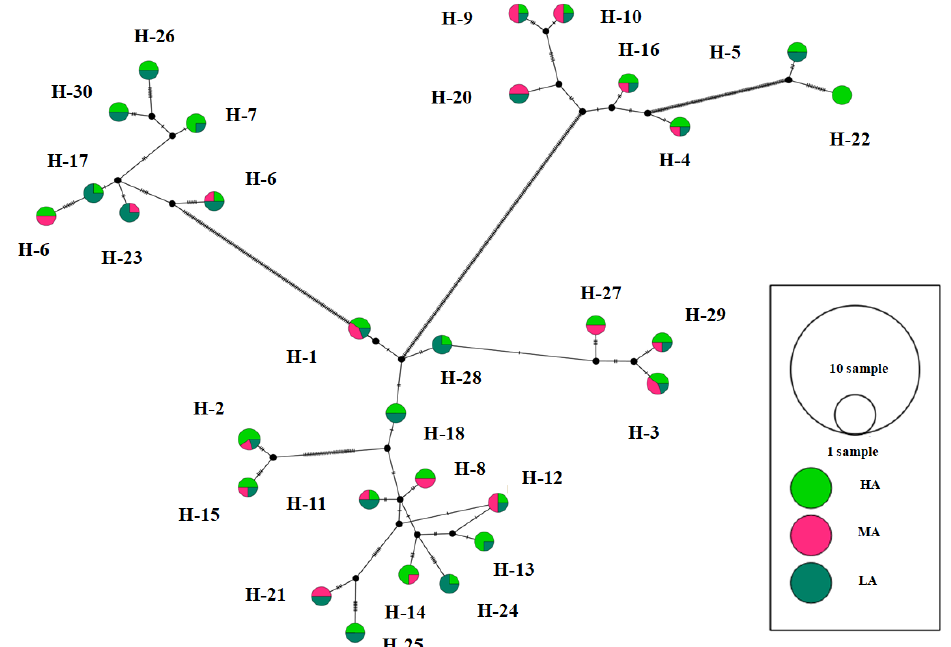
Figure 6. Median joining network according to different categories of aggressiveness of FG haplotypes. Size of the circle is related with aggressivity of the haplotypes. Colors indicate the proportion of individuals depicting the same level of the study area. HA: Highly aggressive; MA: Moderately aggressive and LA: Least aggressive.